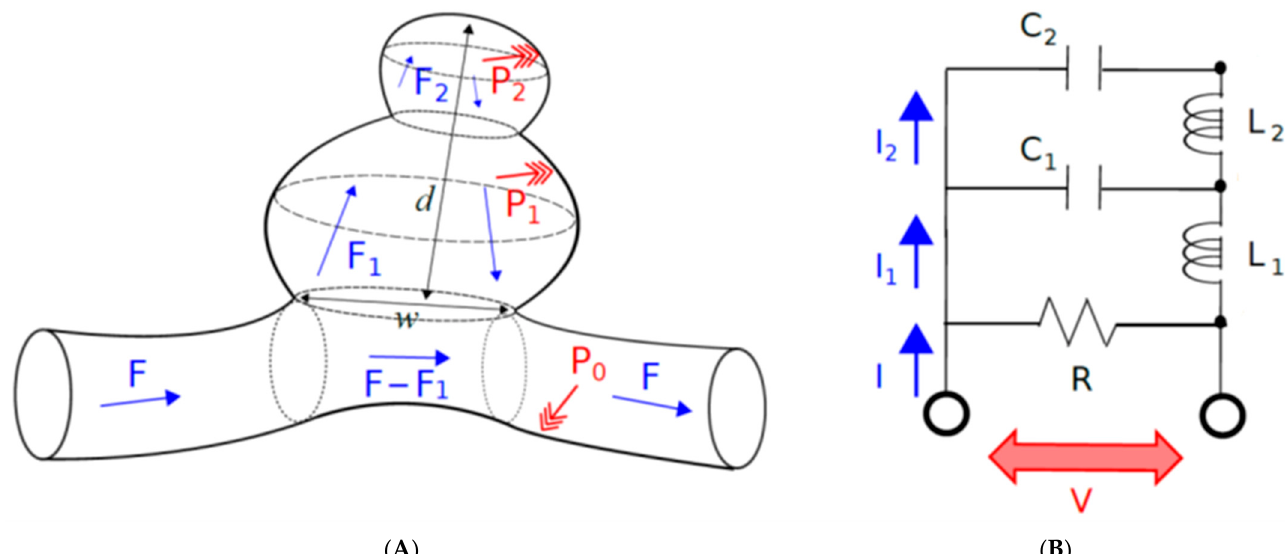
Figure 1. ( A ) Doubly composed intracranial aneurysm consisting of mother and daughter aneurysms (also called dumbbell-shaped aneurysm in the preceding works). The blood flow F is the amount of blood flow pumping from the heart, F 1 is the blood flow in the mother aneurysm and F 2 is the blood flow in the daughter aneurysm, where the circulative flows with the opposite direction are assumed in the aneurysms. ( B ) Solitonic Windkessel model for the doubly composed intracranial aneurysm. The corresponding electric circuit is shown, where C 1 and C 2 corresponds to the size/dimension of mother and daughter aneurysms, respectively. R determines the branching ratio F 1 = F of the blood flow. The constants L 1 and L 2 are related to the elasticity of blood vessel wall. P 0 , P 1 and P 2 denote the local pressures, and F , F 1 , and F 2 are blood flows.